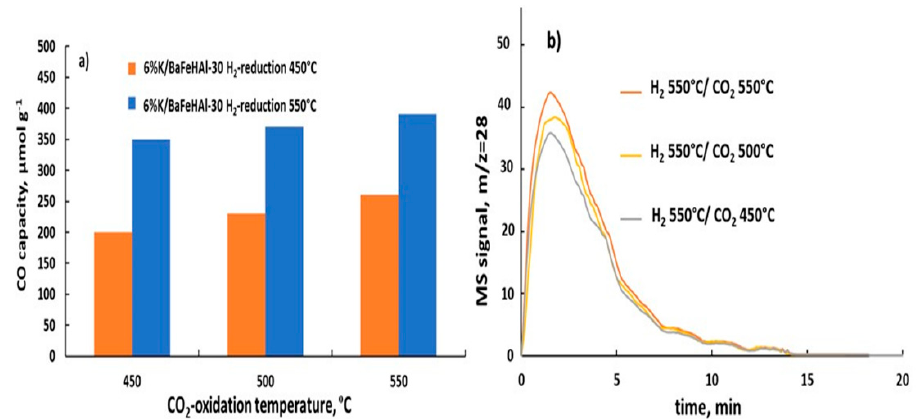
Figure13. E ff ectofCO 2 oxidationtemperatureinRWGS-CLcyclesatconstantH 2 -reductiontemperature Figure 13. Effect of CO 2 oxidation temperature in RWGS-CL cycles at constant H 2 -reduction temperature of 550 °C on the CO capacity of 6%K/BaFeHAl-30 catalyst ( a ) and CO evolution spectra ( b ).